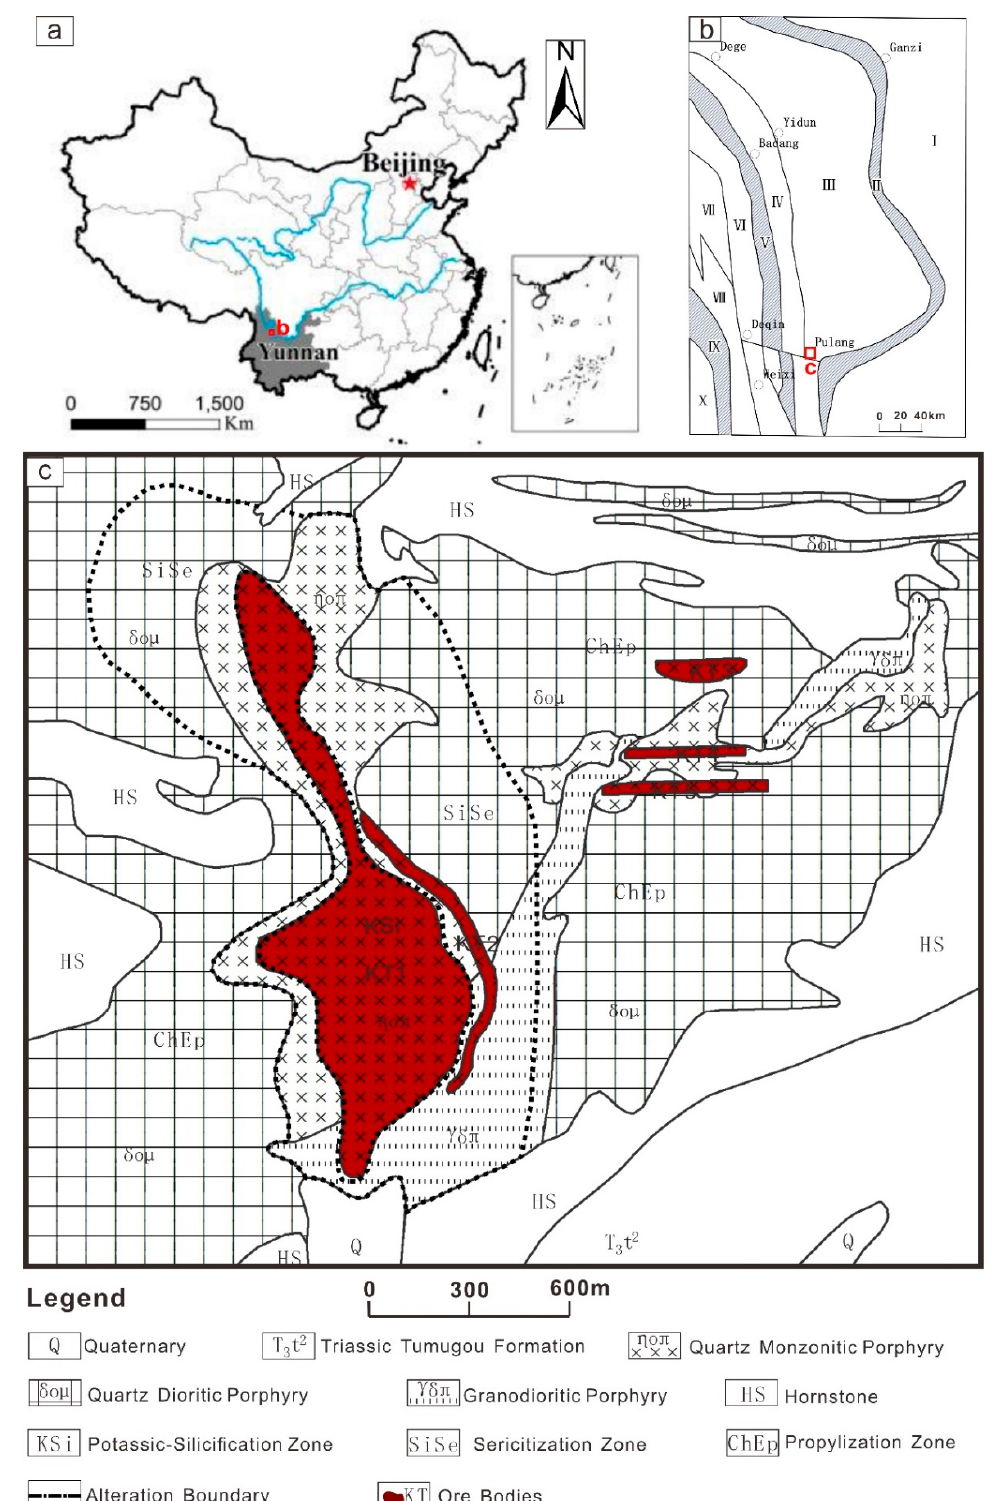
Figure 1. Geological map of the Pulang PCD (modification of the map reported by Wang et al. [52]). ( a ) Location map of the study area; ( b ) Tectonic map of the Yidun island arc; ( c ) Simplified geological map of the Pulang PCD. I—Yangtze plate; II—Ganzi-Litang plate junction belt; III—Yidun island arc; IV—Zhongza microblock; V—Jinsha River junction zone; VI—Janda-Wixi volcanic arc; VII—Changdu-Lanping block; VIII—Sanda mountain-Jinghong volcanic arc; IX—Lancang River junction belt; X—Baoshan block.